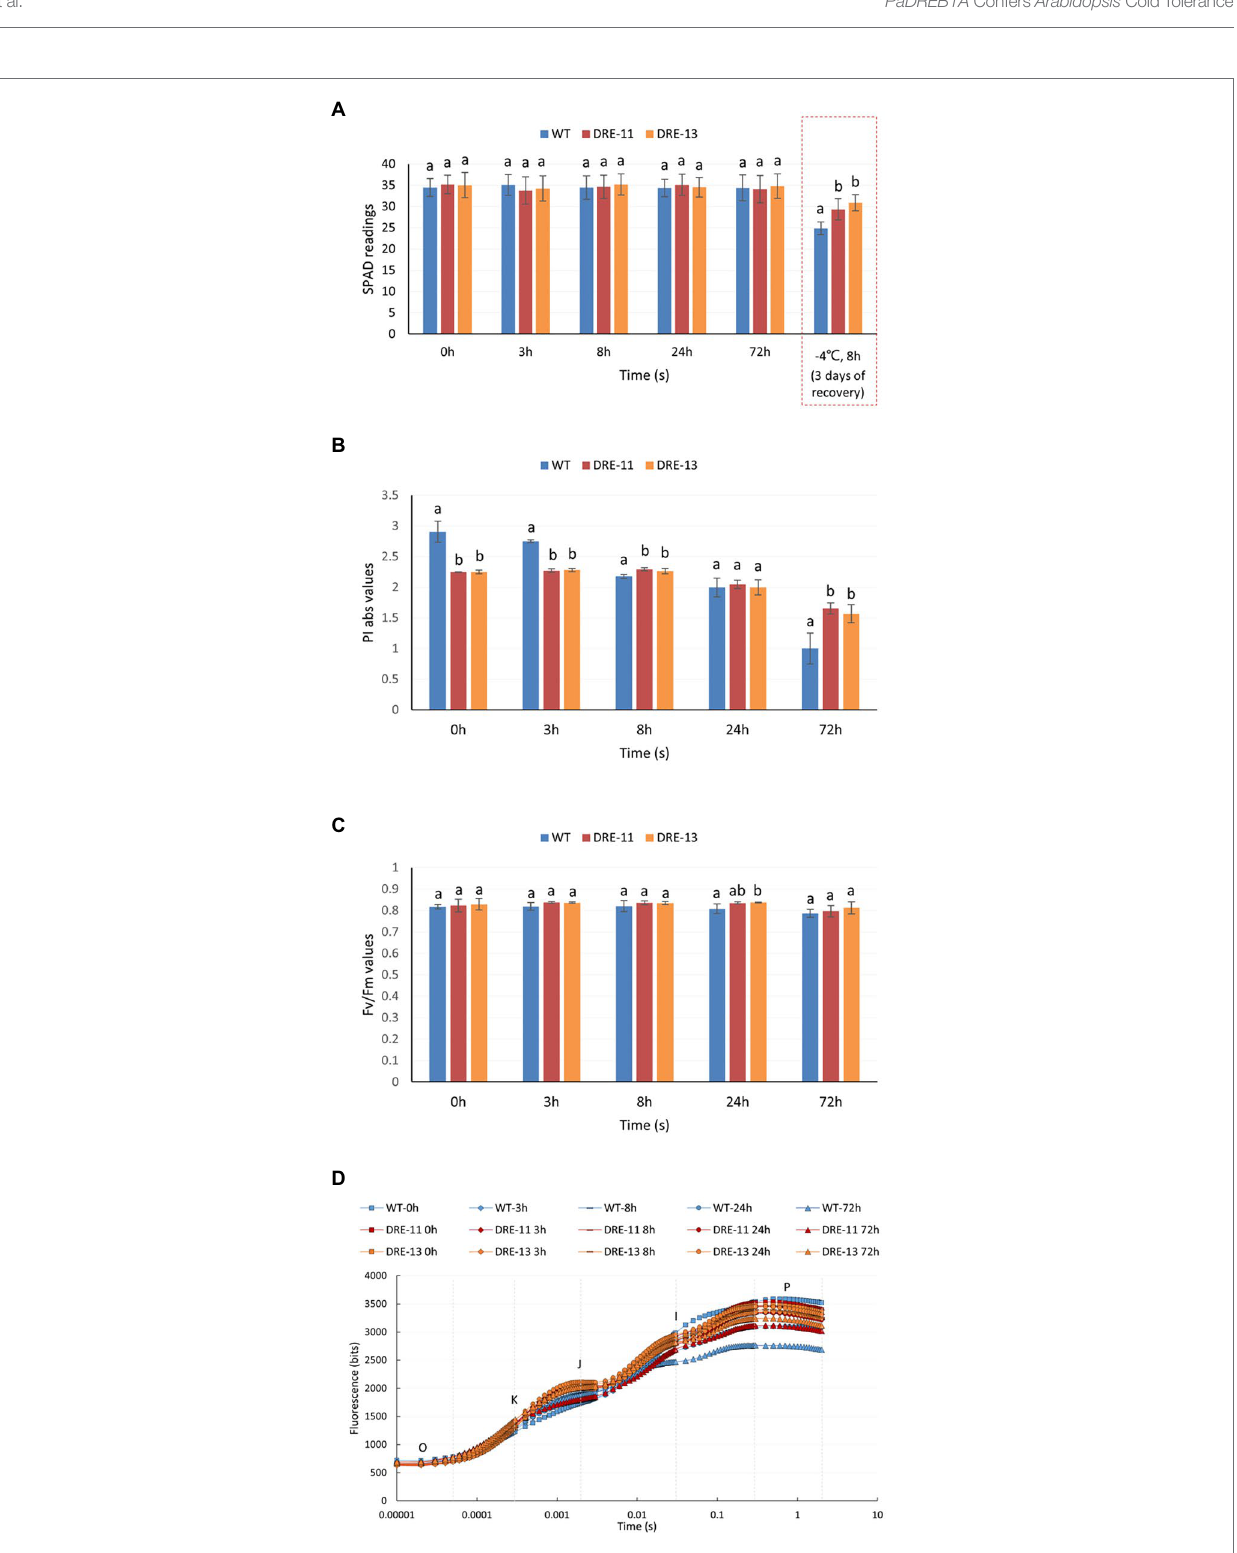
FIGURE 6 | Chlorophyll content and chlorophyll fluorescence parameters of PaDREB1A transgenic lines and WT plants after different cold stress treatment times. (A) SPAD readings. The dotted box shows an additional set of ice stress tests. (B) PI abs values and (C) Fv/Fm values. Means with the same letters are non-significantly different for different transgenic lines and WT plants. (D) Fast chlorophyll fluorescence induction curve. O, K, J, I, and P are the characteristic